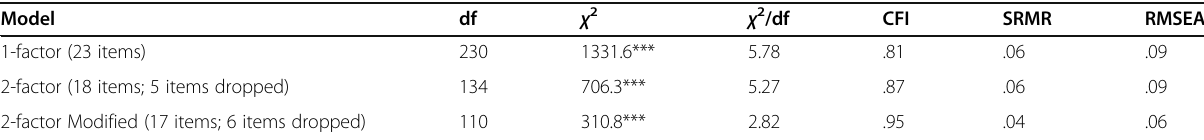
Table 4 Model fit indices